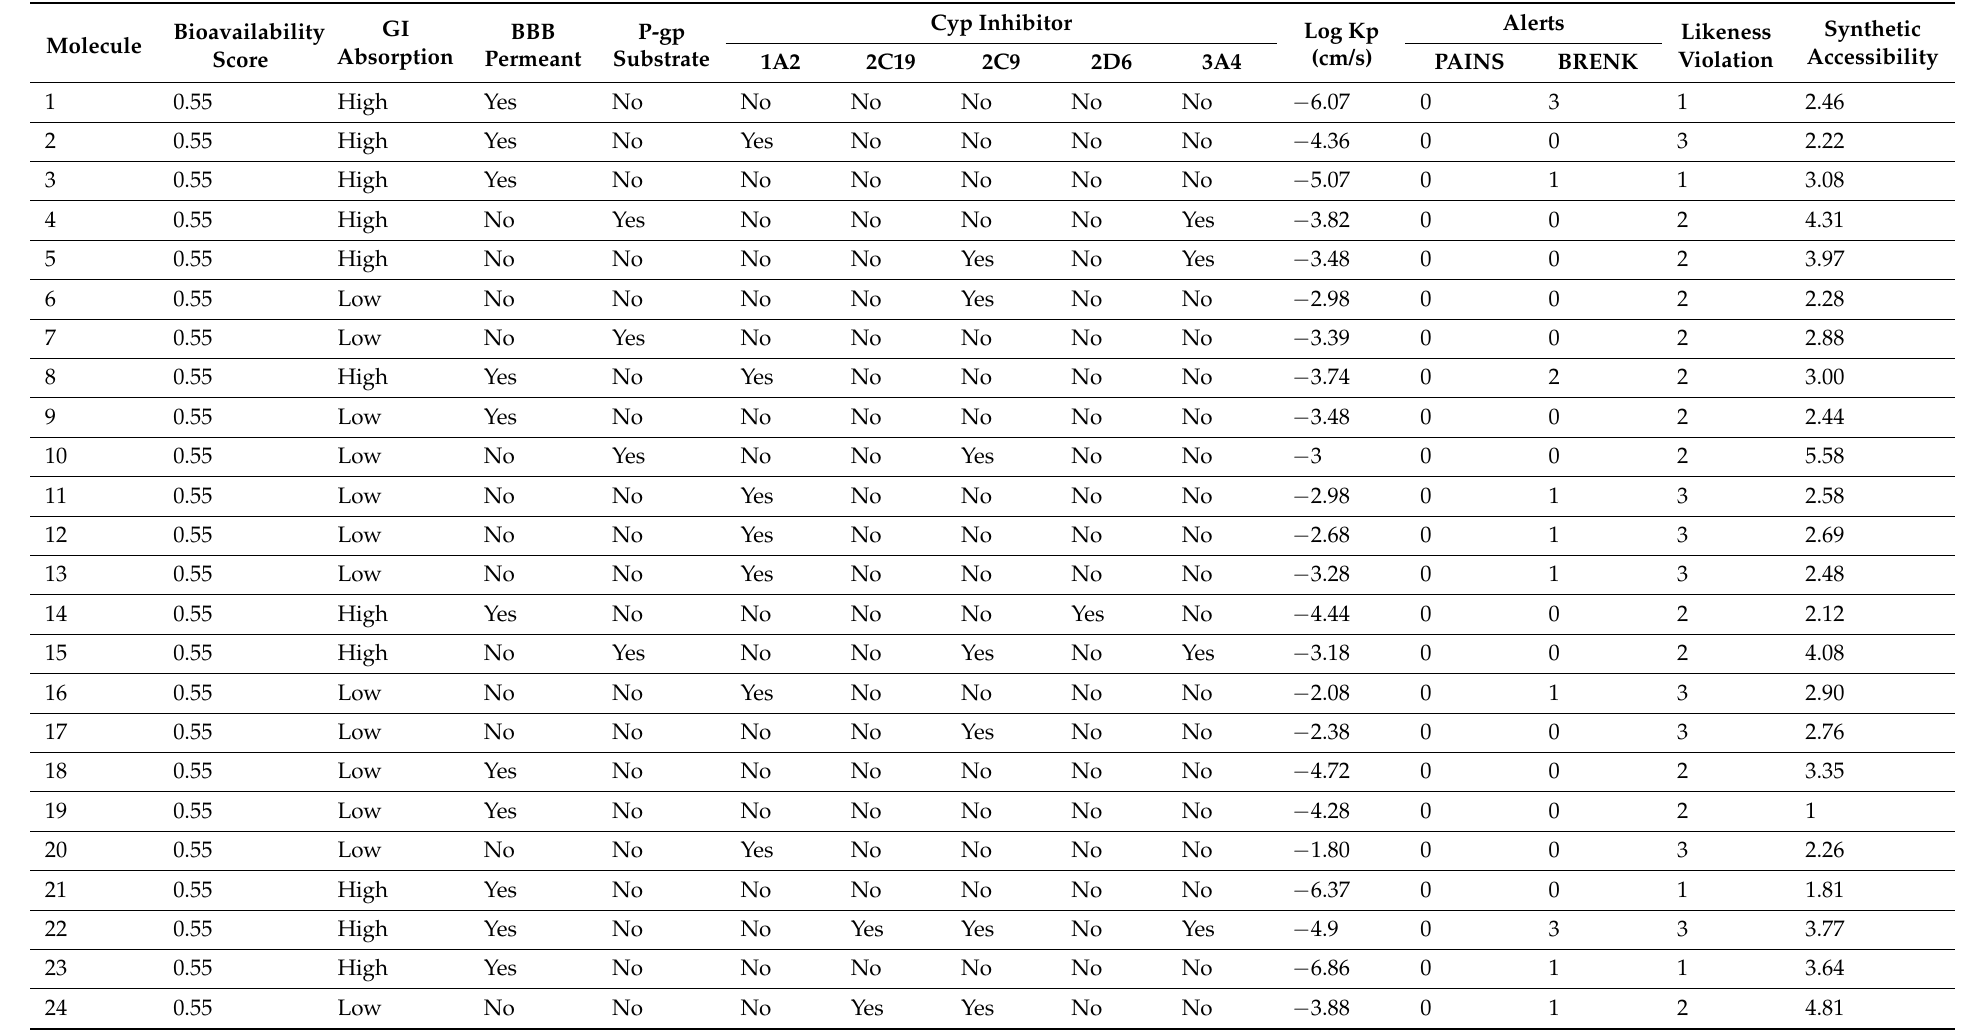
Table 5. Pharmacokinetic results of the identified compounds from B. cernua